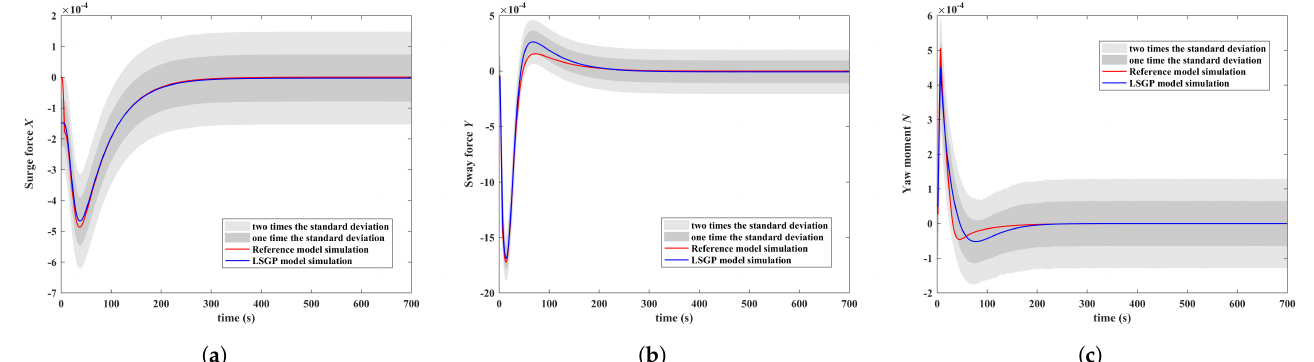
Figure 6. Comparison results of non-dimensional with the simulated T-25 ◦ test. ( a ) is about the Surge force of the “mariner”; ( b ) is about the Sway force of the ship; ( c ) is the situation of Yaw moment of the ship; the figure shows one and two times the standard deviation bandwidth